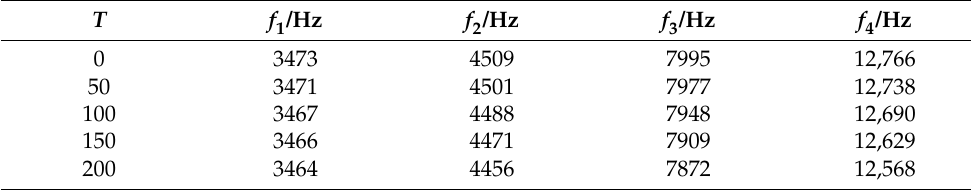
Table 5. Static frequency of vibration mode in different